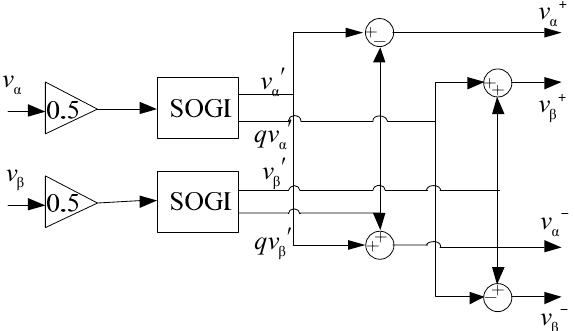
Figure 6. Positive and negative sequence separation generated by the double second-order generalized integrator.